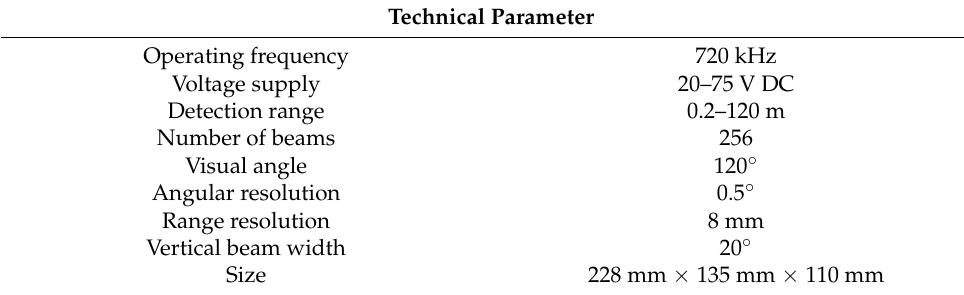
Table 1. Technical parameters of Gemini 720i.